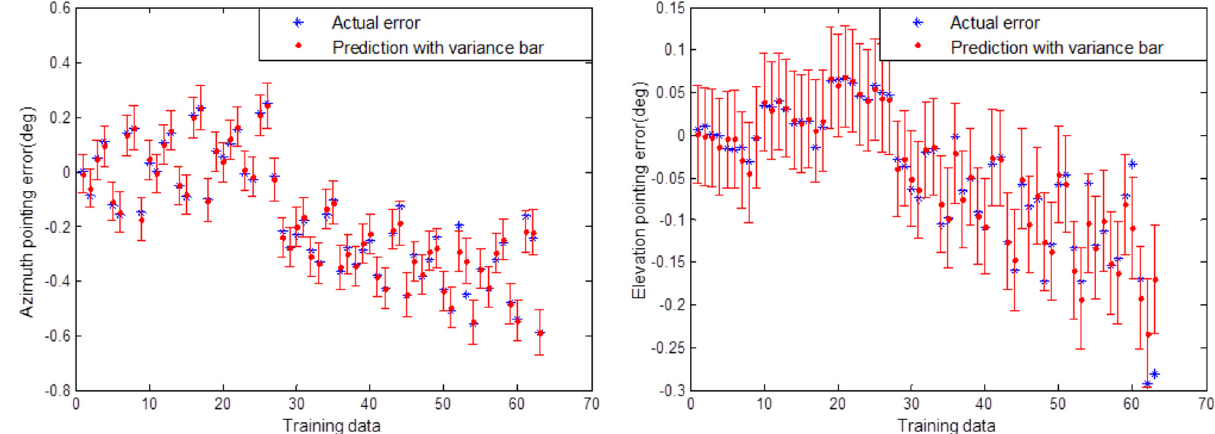
Fig. 3. Prediction results for the training